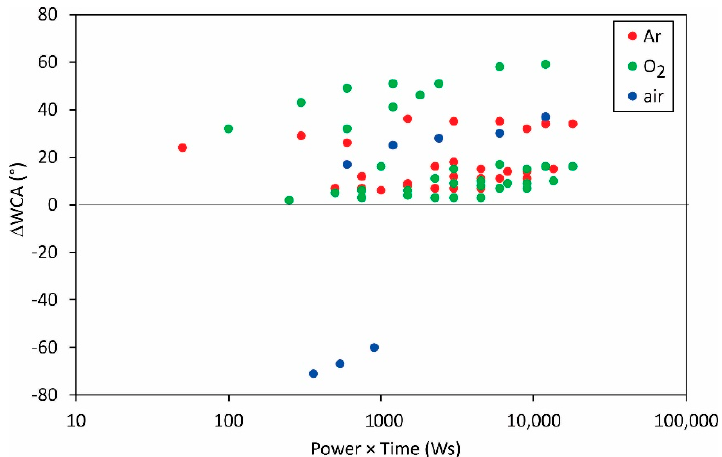
Figure 11. The difference between the initial static water contact angle and the WCA after the treatment versus the product of the reported discharge power and treatment time. The same applies to the variation of the F/C and O/C ratios as deduced from XPS measurements (Figures 12 and 13).